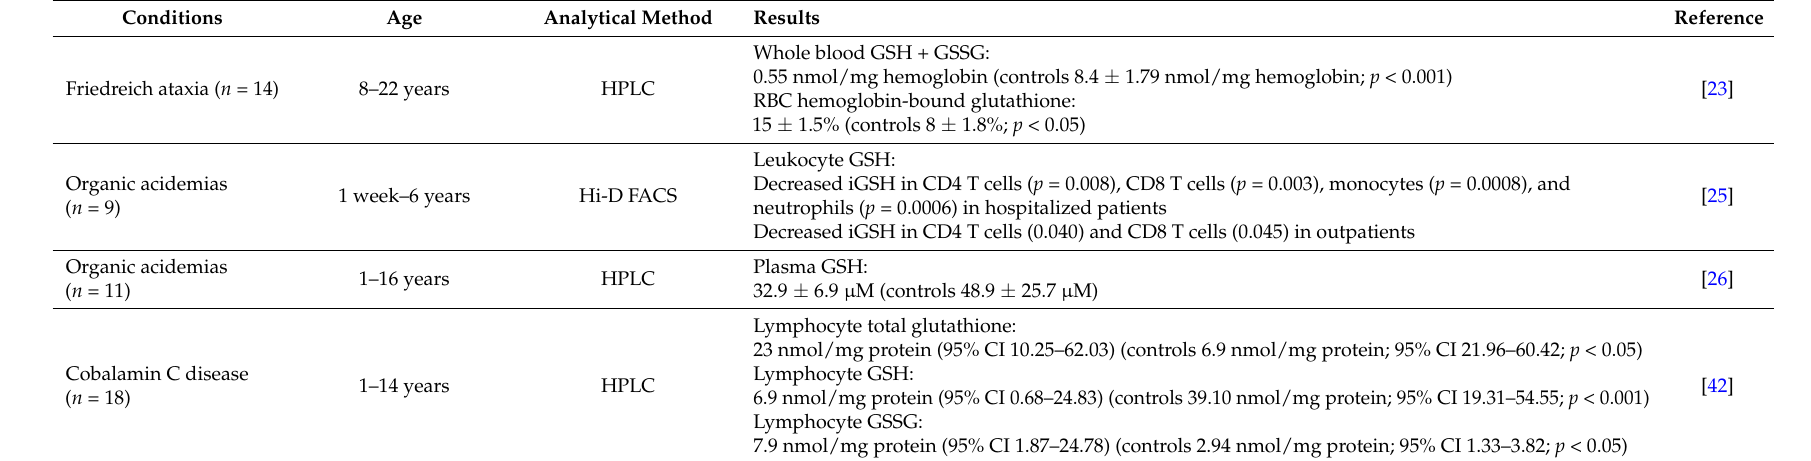
Note: The glutathione status as determined by different analytical methodologies in mitochondrial disease or organic acidemia patients is shown above. Statistical significance is shown where possible as provided by the individual references. CI = confidence interval; CPEO = chronic progressive external ophthalmoplegia; GSH = reduced glutathione; GSSG = glutathione disulfide; HiD-FACS = high-dimensional fluorescence-activated cell sorting; HPLC = high-performance liquid chromatography; iGSH = intracellular reduced glutathione; LC-MS/MS = liquid chromatography-tandem mass spectrometry; RBC = red blood